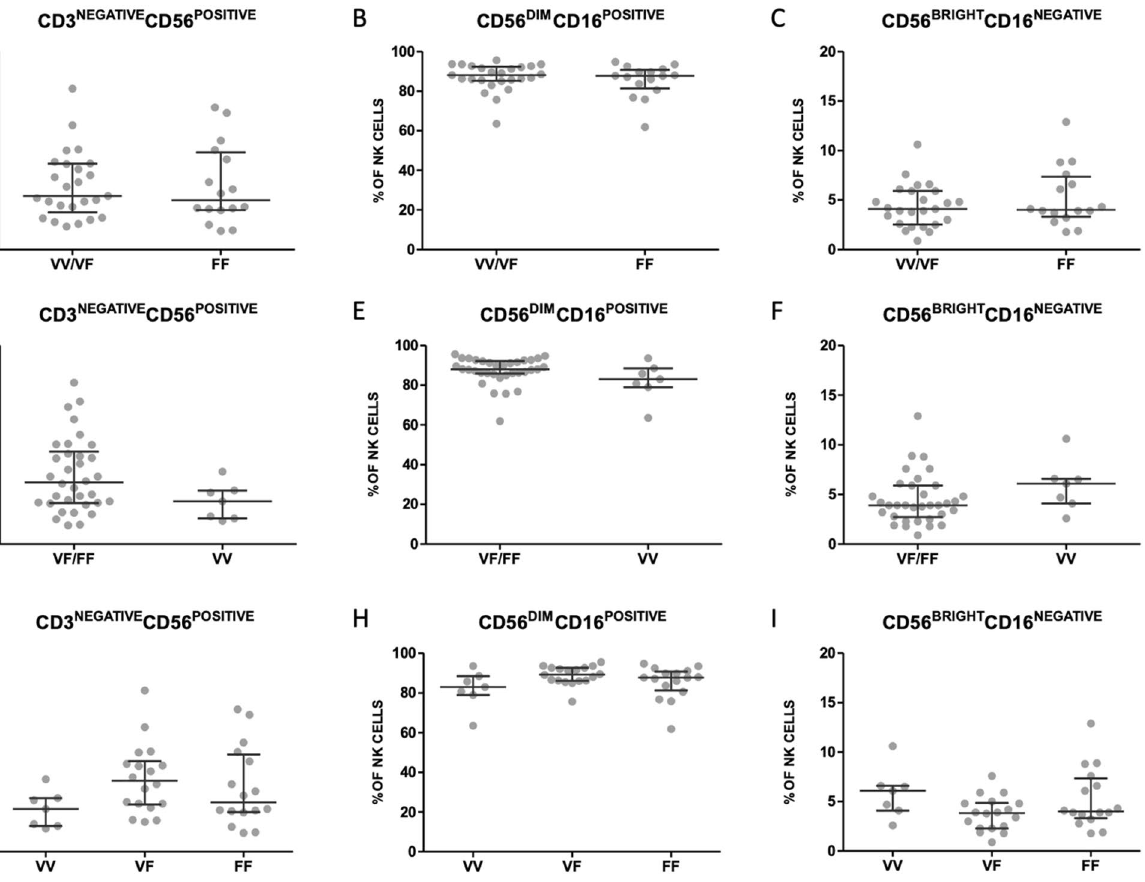
Figure 2. Frequencies of NK cell subsets in women with RPL genotyped for CD16a. Percentage of total CD3 negative CD56 positive NK cells from lymphocytes ( A ), CD56 dim CD16a positive NK cells ( B ) and CD56 bright CD16a negative NK cells ( C ) as measured by flow cytometry in women whose genotyping demonstrated FCGR3A -p.176 at least one valine allele (VV/VF) versus (FF) ( A / B / C ) or at least one phenylalanine allele (VF/ FF) versus (VV) ( D / E / F ) or VV, VF and FF ( G / H / I ) respectively. Dots depict individuals, lines depict median and inter quartile range per